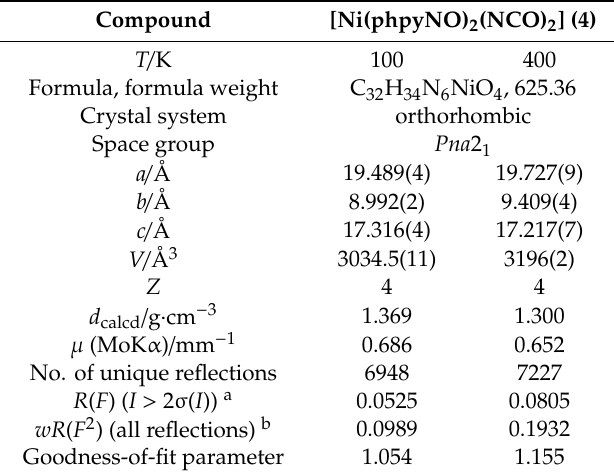
Table 1. Selected crystallographic parameters of 4